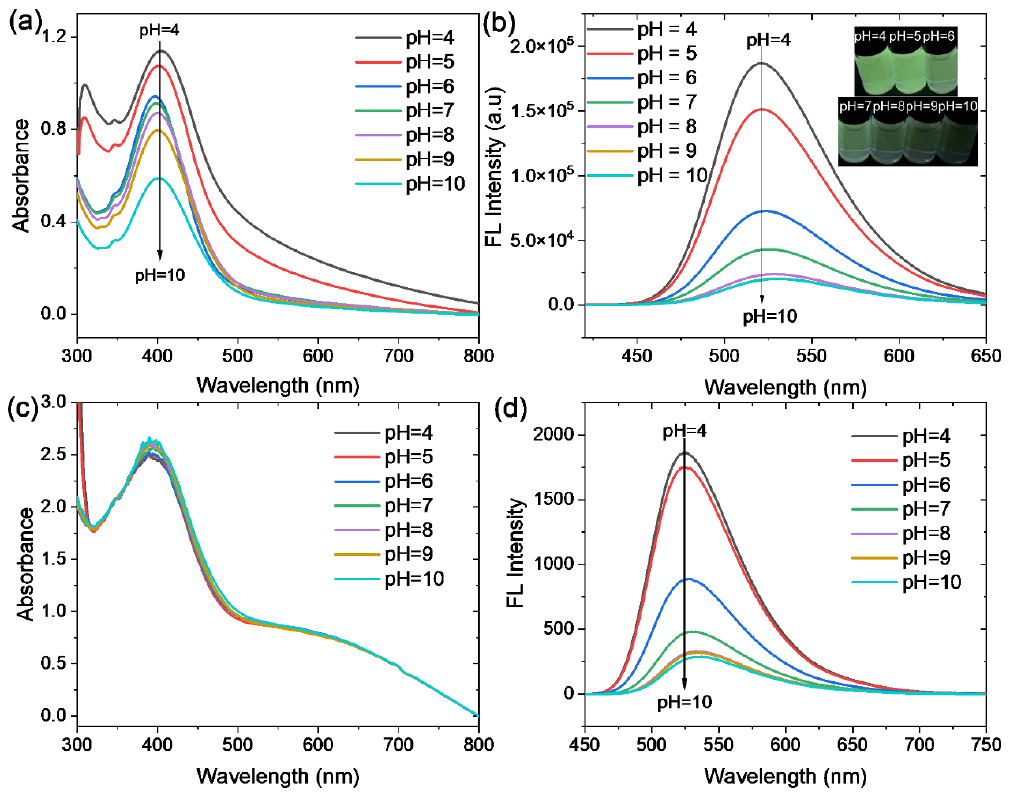
Figure 4. The UV absorption spectra of ( a ) PNI-SBMA and ( c ) PNI-SBMA/PVANFM in solution with pH = 4 – 10; the fluorescence spectra of ( b ) PNI-SBMA and ( d ) PNI-SBMA/PVA NFM in solution with pH = 4 – 10.